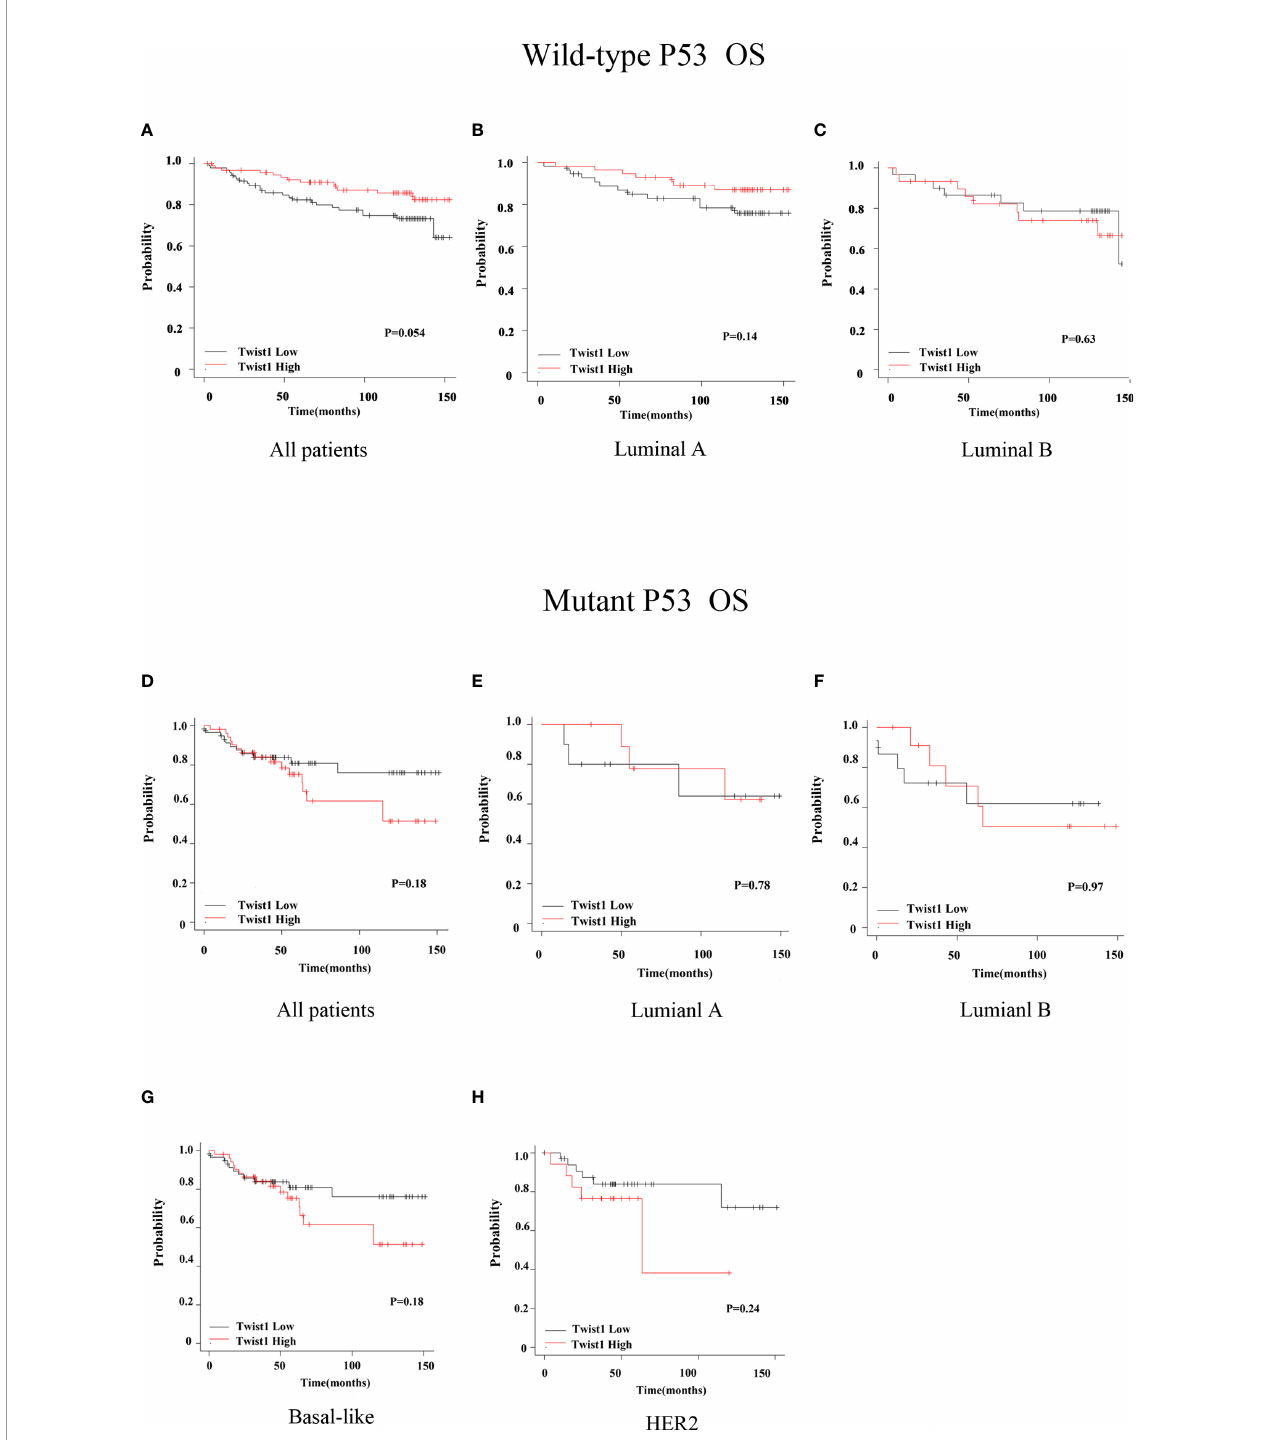
FIGURE 3 | Comparison of OS for wild-type or mutant p53 breast cancer patients with different Twist1 levels. (A – C) Different Twist1 expression levels did not differ in OS ( P > 0.05) among all wild-type p53 breast cancer patients (A) and luminal A (B) and luminal B (C) subtypes. (D – G) Different Twist1 expression levels did differ OS ( P > 0.05) among all mutant p53 breast cancer patients (D) and luminal A (E) , luminal B (F) , and basal-like (G) subtypes (H) HER2